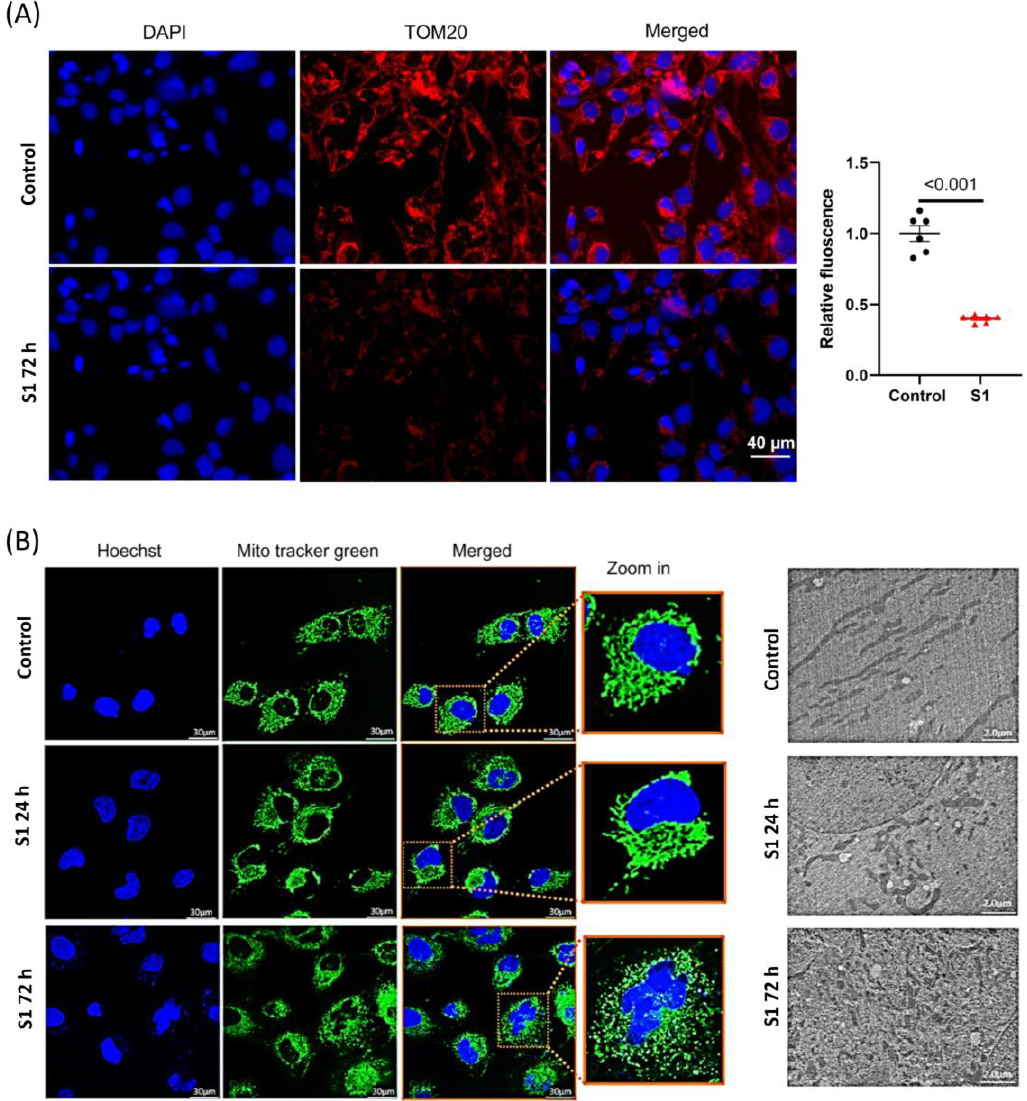
Figure 4. The effects of S1 on mitochondrial dynamics. ( A ) S1 treatment for 72 h decreased TOM20 expression, which is important in transporting essential proteins from cytosol to mitochondria in- cluding mitochondrial transcription factors and ETC complex subunits ( n = 6 independent experi- ments). ( B ) Mitochondrial morphology evaluated using confocal fluorescence microscopy and transmission electron microscopy. S1 protein disrupted mitochondrial networks and led to mito- chondrial fragmentation and mitochondrial fission within 72 h but not within 24 h ( n = 50 different cells were evaluated for treatment and control).